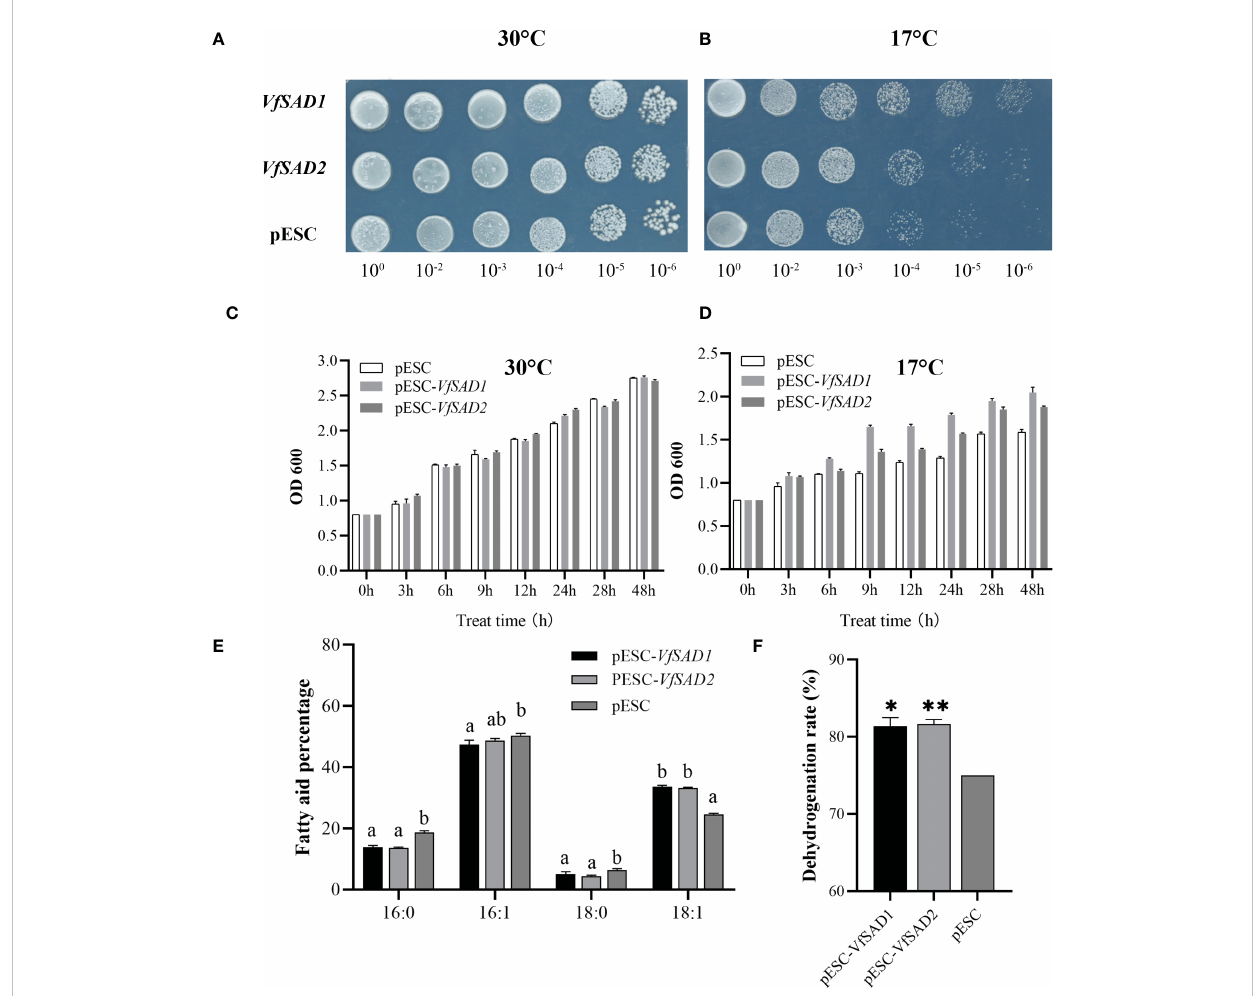
FIGURE 5 VfSAD1 and VfSAD2 enhance the tolerance of yeast to low temperature stress. (A, B) Yeast colonies at 30°C (A) and 17°C (B) ; (C, D) OD values of yeast liquid cultures treated at 30°C (C) and 17°C (D) ; (E) fatty acid fractions in the BY4741 treated at 17°C; (F) conversion of unsaturated fatty acids in the BY4741 treated at 17°C. The error bar represents the standard deviation (± SD) for setting three biological replicates. Signi fi cant difference was detected by t -test (* indicates p < 0.05; ** indicates p < 0.01). A comparison between groups was conducted by one-way ANOVA test (FA component), and the different letters above the bar chart indicate signi fi cant differences ( p <